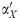
Results given for various combinations of αX and αY in associated datasets were better than Pearson correlation coefficient in the majority of cases.9 heatmaps are shown in the figure, each representing one combination of αX and αY. Each heatmap, calculates BPA for different combinations of αX′ and αY′.
IX was kept equal to IY for the dataset to be associated and X was calculated by the addition of IX and NX and similarly Y. The value of BPA obtained is encoded in color, the darker being higher. Further, below every heatmap the corresponding scatterplot for X and Y is shown. The straight black line shows the relationship function. On the top of every heatmap the normalized mutual information content (MI), the Bayesian Probability of Association (BPA, for the correct choice of αX′ and αY′ which is equal to αX and αY respectively) and the Pearson correlation value (PC) has been displayed. On the top of every scatter plot, the values of the Spearman Rank Correlation (SR) and the Kendall Tau Rank Correlation (KT) is also shown. It can be observed that when αX′ and αY′ exceed αX and αY respectively the results start to approach 0.